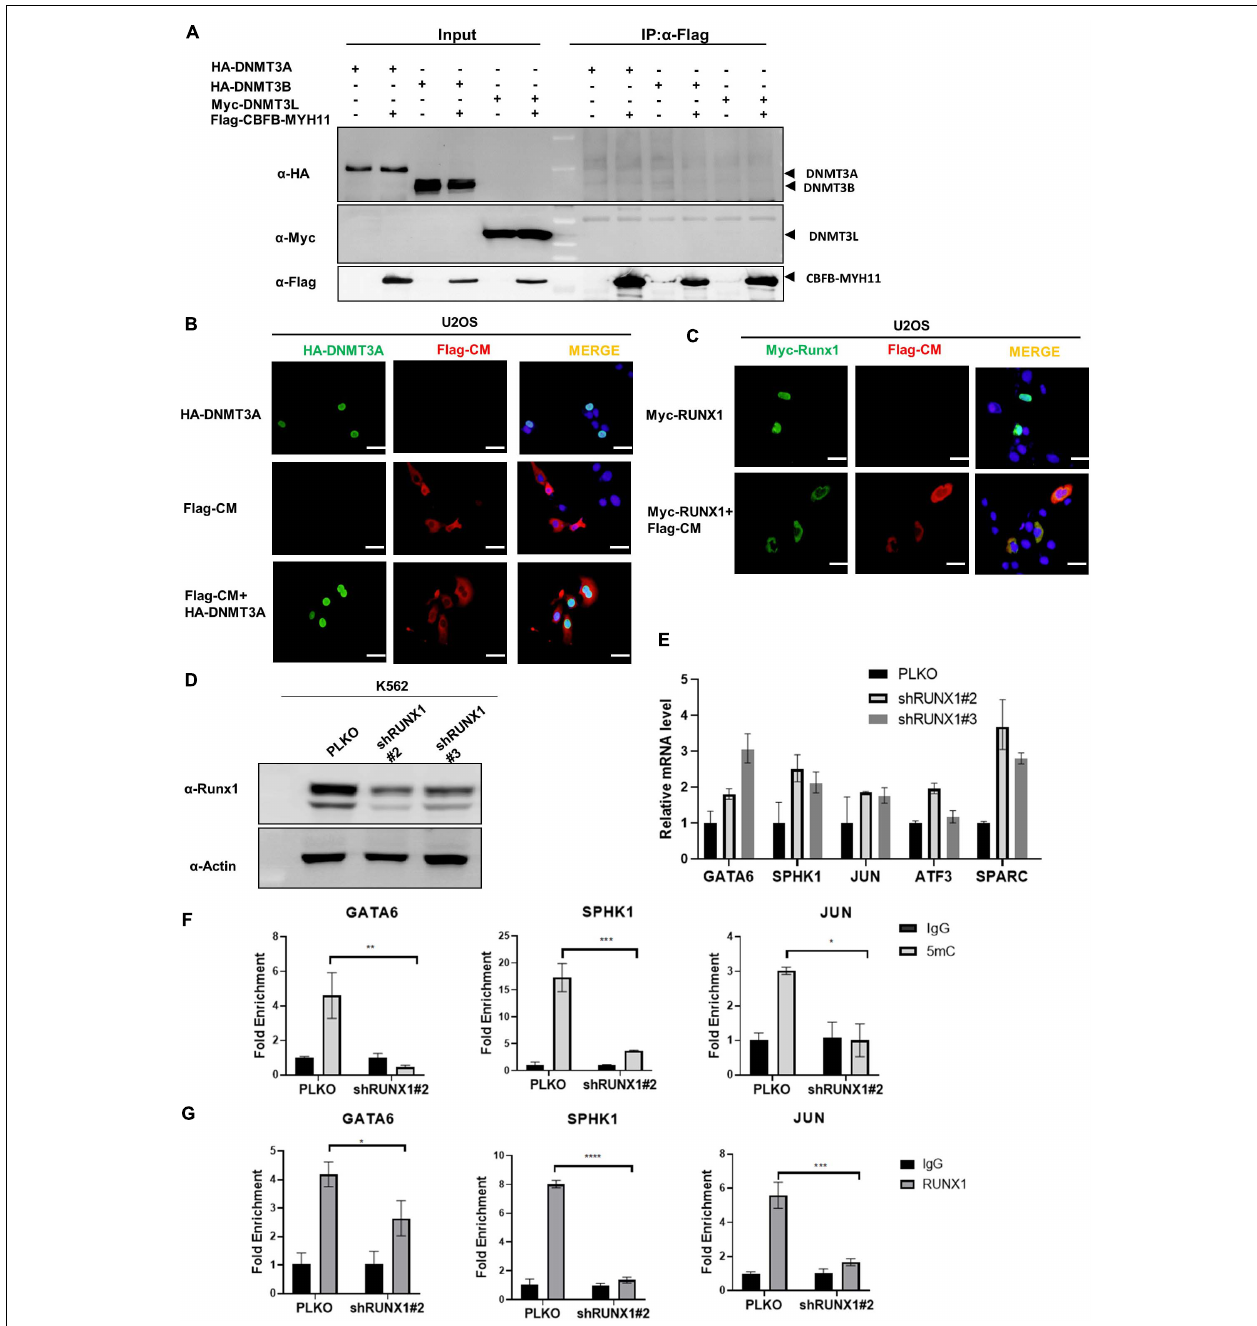
FIGURE 4 | CBFB-MYH11 impairs the methylation of RUNX1 target genes. (A) CBFB-MYH11 does not interact with DNMT3A, DNMT3B, or DNMT3L. Plasmids expressing the indicated proteins were transiently transfected in HEK293T cells. CBFB-MYH11 fusion protein was purified by immunoprecipitation with Flag beads, followed by Western blot to detect the interaction with DNMT3A, 3B, or 3L with antibodies against HA or Myc. (B) CBFB-MYH11 and DNMT3A were located in different subcellular compartments. Flag-tagged CBFB-MYH11 and/or HA-tagged DNMT3A were transfected into U2OS cells. After 36 h, cells were fixed with 4% paraformaldehyde followed by immunofluorescence staining with indicated antibodies. DAPI (blue) was used for DNA staining. Scale bars: 50 µ m. (C) RUNX1 was directed to cytoplasm by CBFB-MYH11 fusion protein. Flag-tagged CBFB-MYH11 and/or Myc-tagged RUNX1 were transfected into U2OS cells. Immunofluorescence was performed as in (B) . Scale bars: 50 µ m. (D,E) AML associated genes were up-regulated in RUNX1 deficient cells. RUNX1 was knocked down by shRNAs in K562 cells. Expression of AML associated genes was determined by RT-PCR. Data were normalized by the mRNA expression level in control cells. (F) 5 mC level of GATA6, SPHK1, and JUN genes in K562 cells was reduced by RUNX1 knocking-down. 5 mC level was determined by MeDIP-qPCR. Mouse IgG was included as a negative control. (G) RUNX1 enrichment at GATA6, SPHK1 and JUN determined by ChIP-qPCR. Rabbit IgG was induced as a negative control. Data are shown as mean ± SEM from experiments performed in triplicate. Asterisks denote statistical significance with two-way ANOVA. * p < 0.05; ** p < 0.01; *** p < 0.001; **** p < 0.0001 for the indicated comparison.